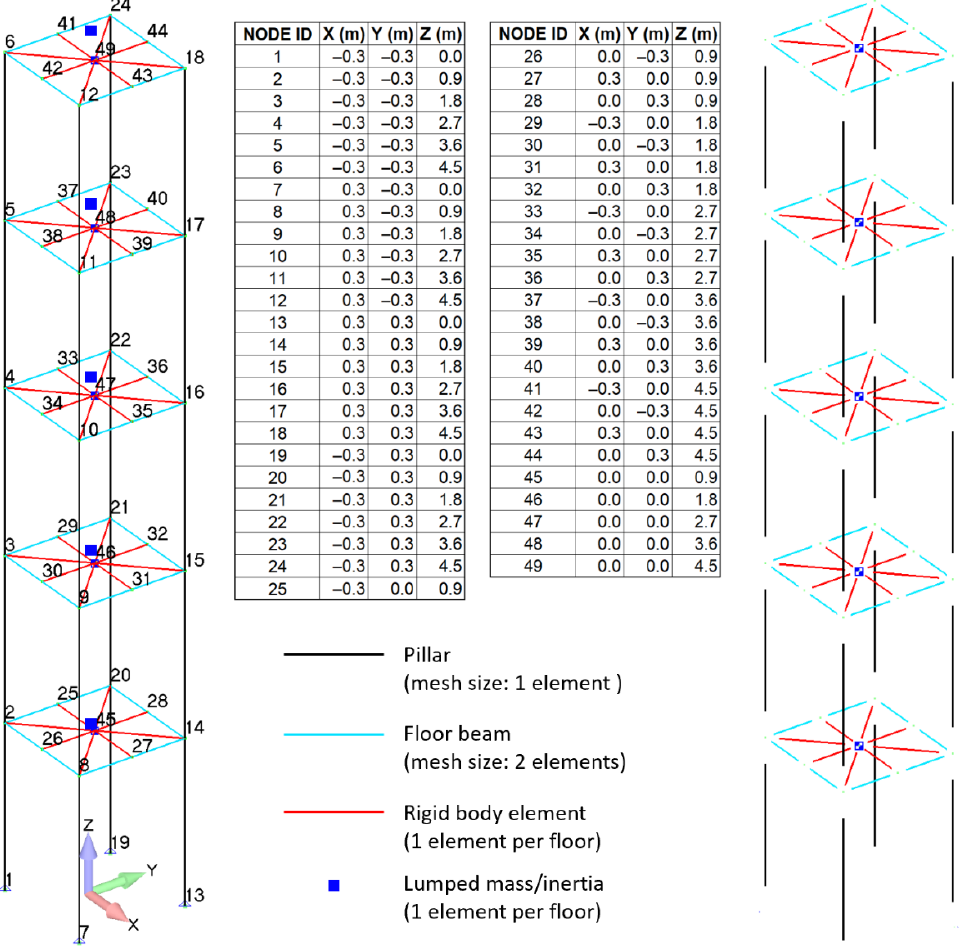
Figure 3. Finite element model of the reference structure, grids, and